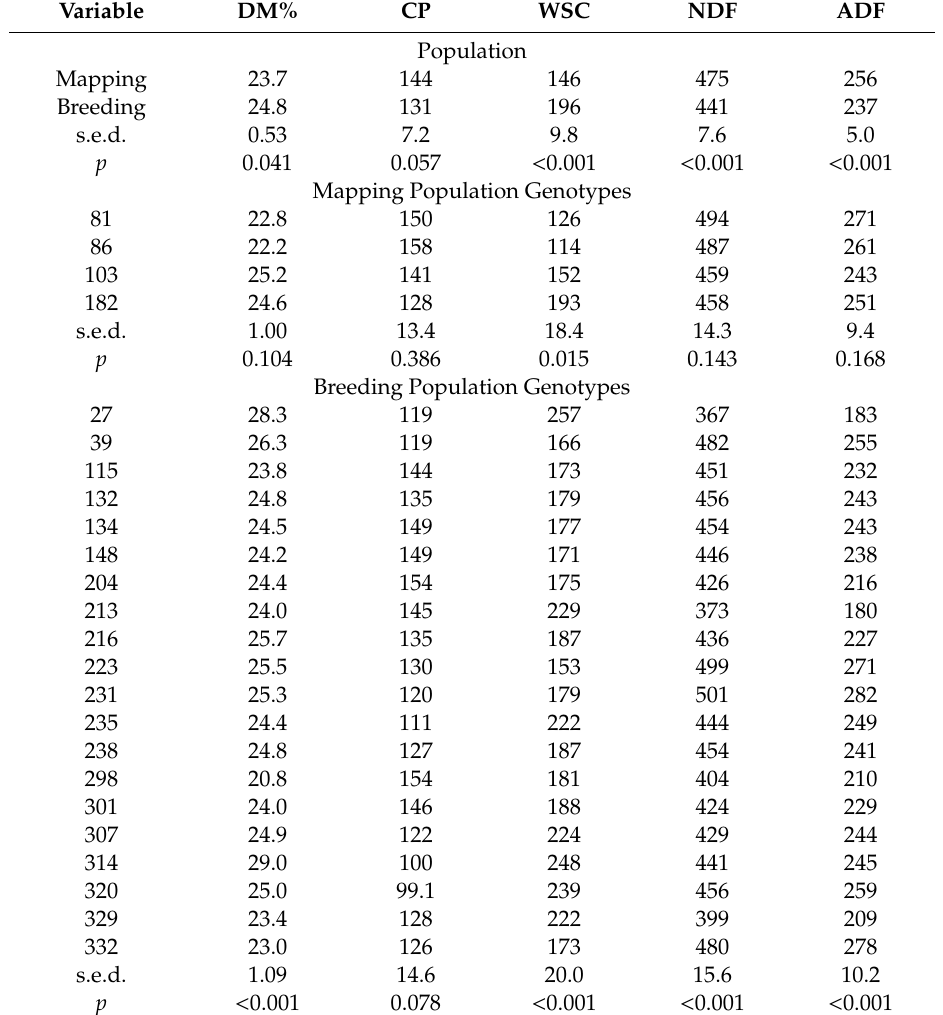
Table 1. Dry matter percentage and feed value (g kg − 1 DM) of perennial ryegrass genotypes from two distinct